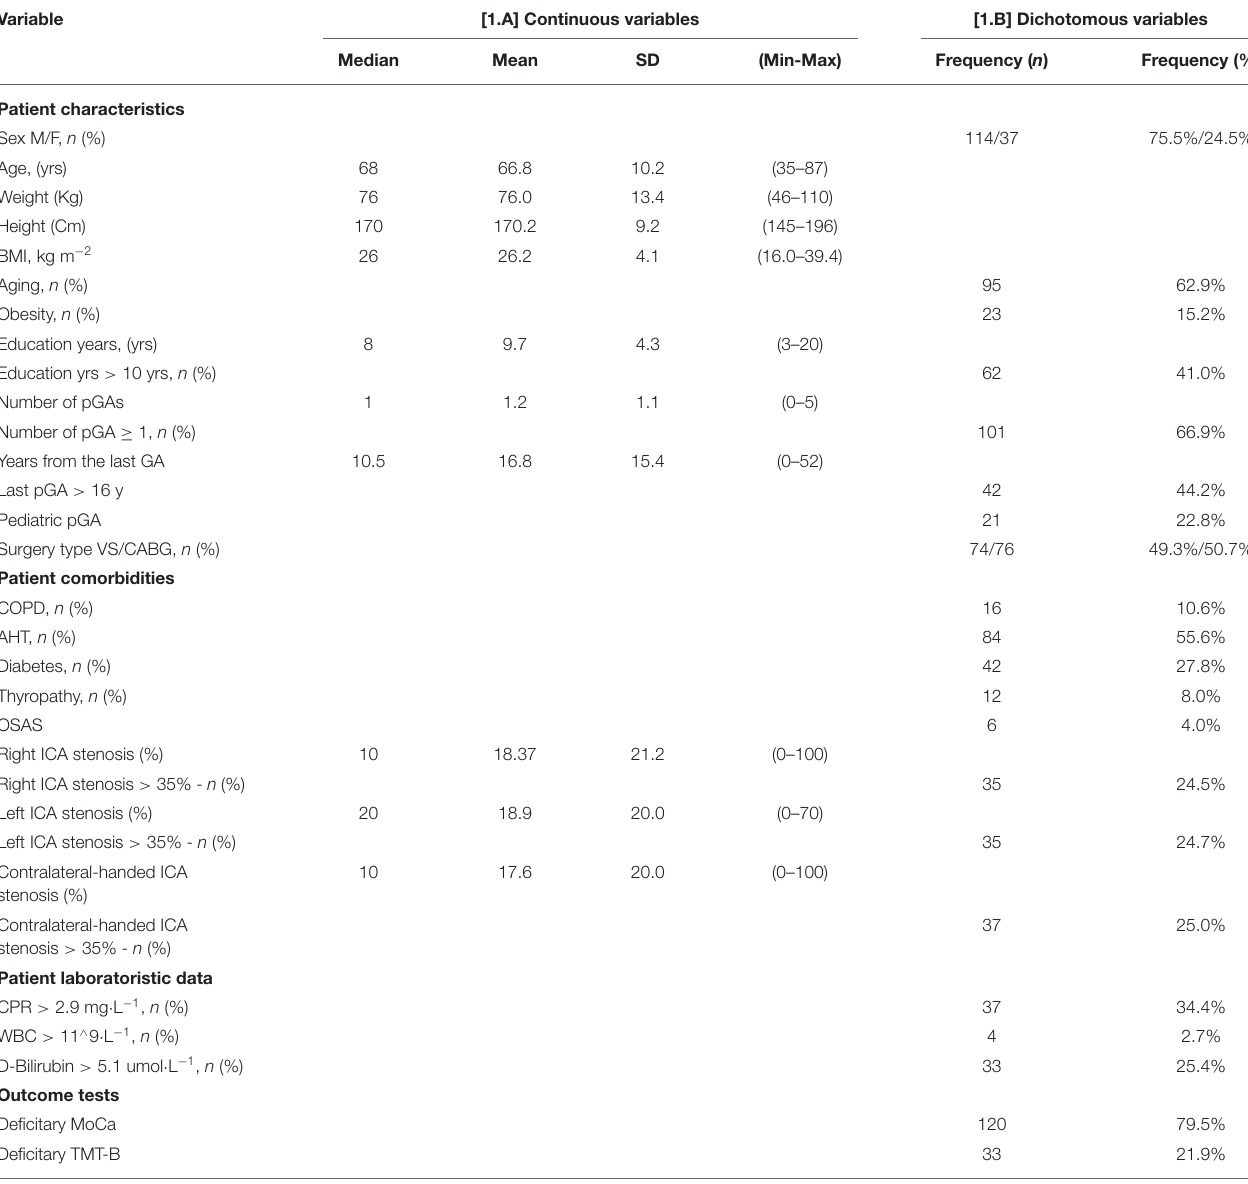
TABLE 1 | General patient, drug, and monitoring characteristics based on baseline cognitive impairment.